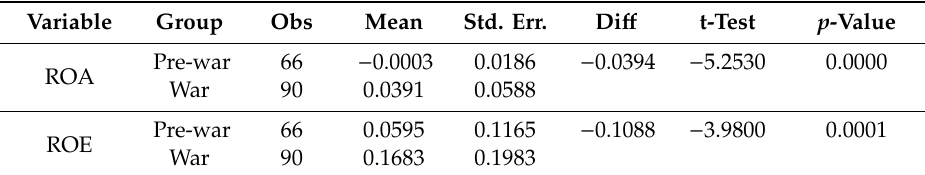
Table 7. T-test (mean comparison